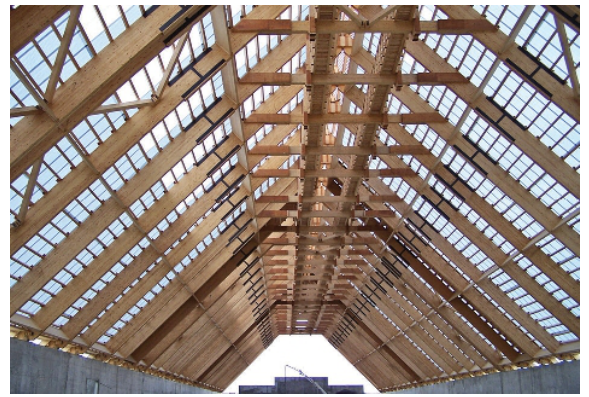
Fig. 1. Semi rigid beam to beam mounting joints in timber structures (object Bulk Warehouse in Russia, Temriuk